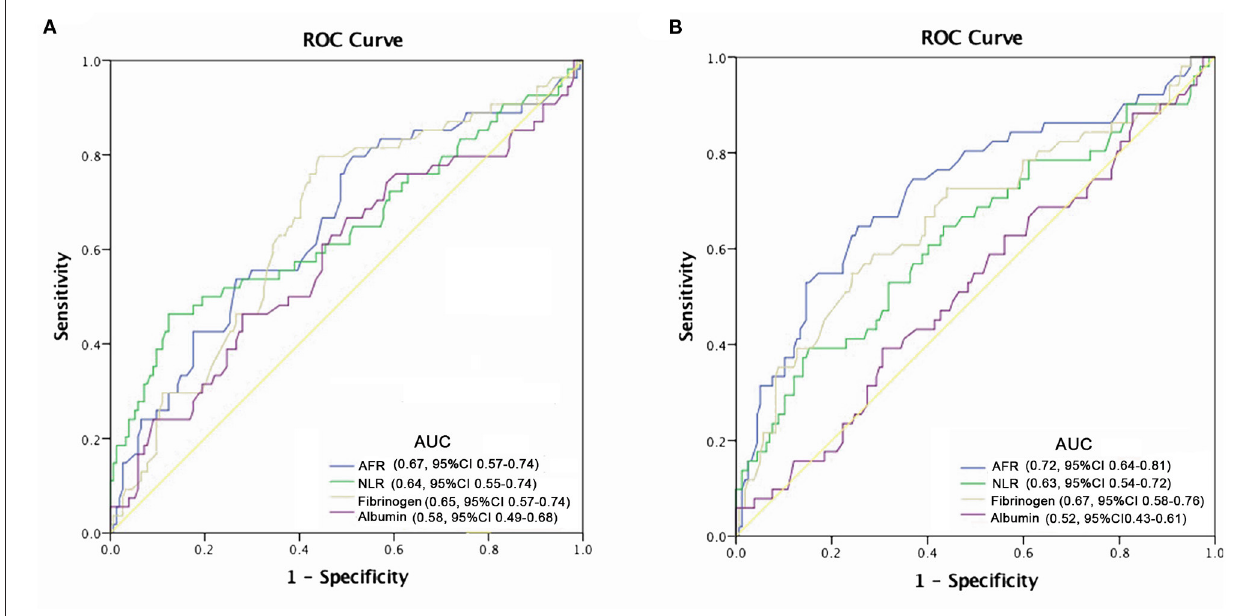
FIGURE 3 | Crude analysis comparing all-cause and cardiovascular mortality between AFR groups. Cumulative mortality curves for (A) all-cause mortality and (B) cardiovascular mortality. PD, peritoneal dialysis; AFR, albumin to fibrinogen ratio; HR, hazard ratio; CI, confidence